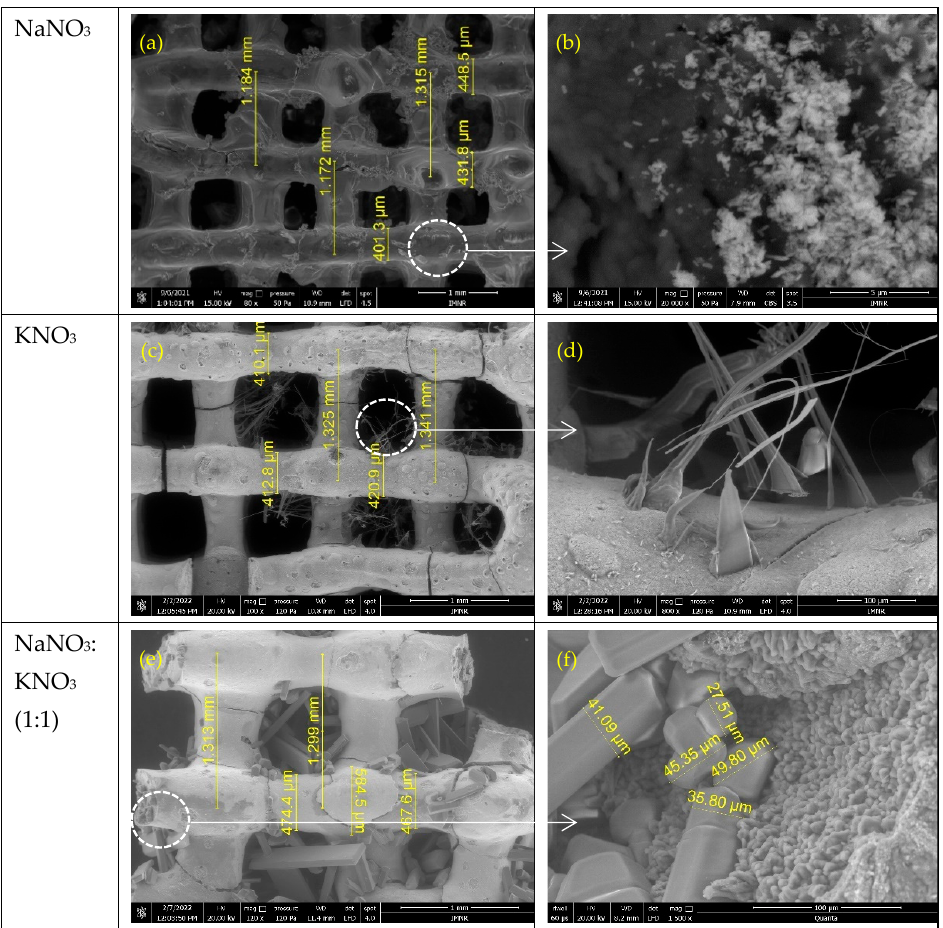
Figure 5. SEM micrographs of ZnO-CNT-based 3D support structure impregnated with PCMs salts: ( a , b ) NaNO 3, ( c , d ) KNO 3 and ( e , f ) NaNO 3 :KNO 3 .